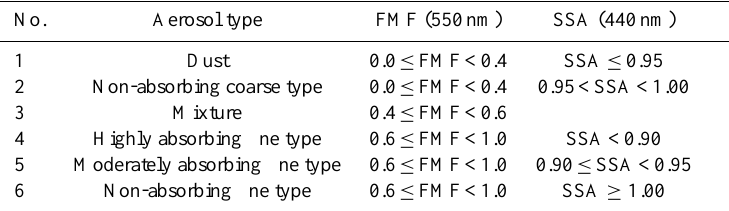
Table 5. Output aerosol types for GOCI YAER according to FMF and